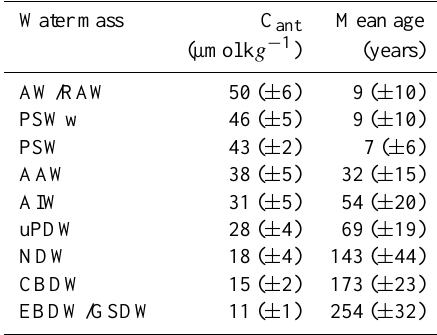
Table 1. Mean ( ± standard deviation) concentrations of anthro- pogenic carbon (C ant ) and mean age in the Fram Strait, separated in water mass